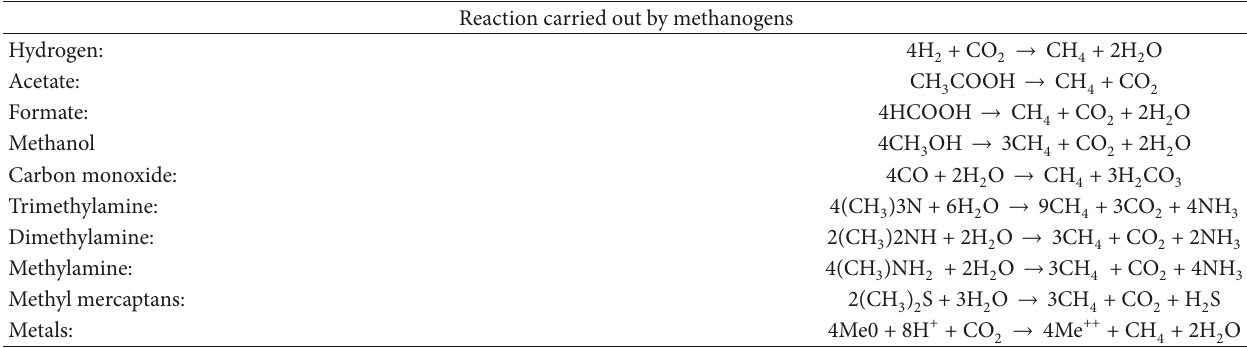
Table 3: Typical reactions carried out by methanogens during anaerobic process